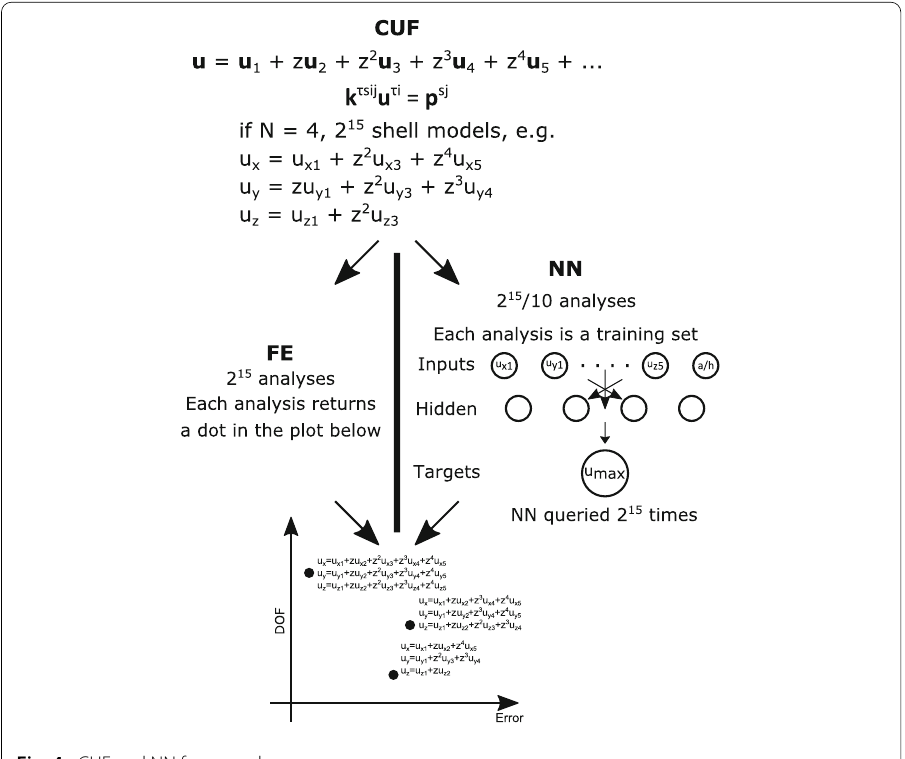
Fig. 4 CUF and NN